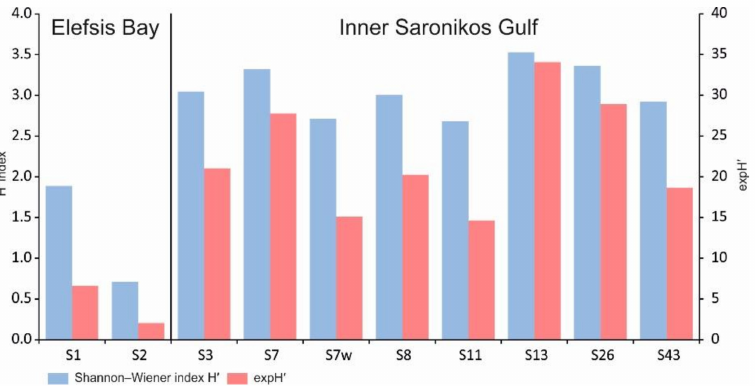
Figure 4. Shannon-Wiener index diversity H’ and expH’.